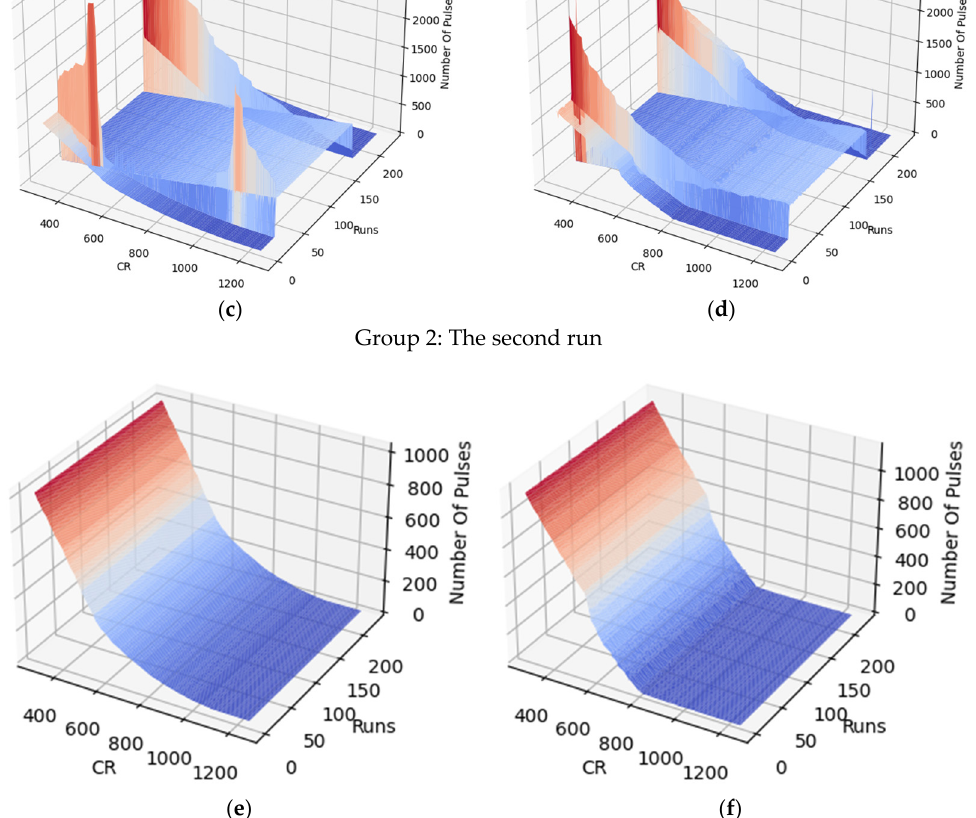
Figure 21. The 3D output of the chip for the second experiment for: ( a ) Run 1, left electrode; ( b ) Run 1, right electrode; ( c ) Run 2, left electrode; ( d ) Run 2, right electrode; ( e ) After washing, left electrode; ( f ) After washing, right electrode.